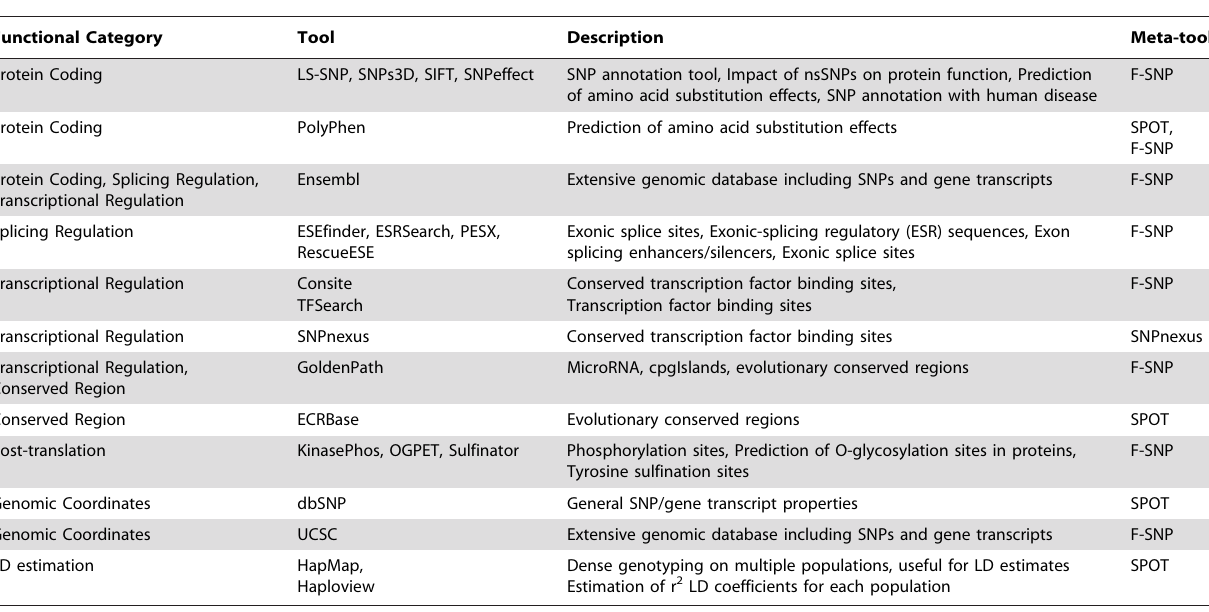
Table 1. Description of data sources used in our regional